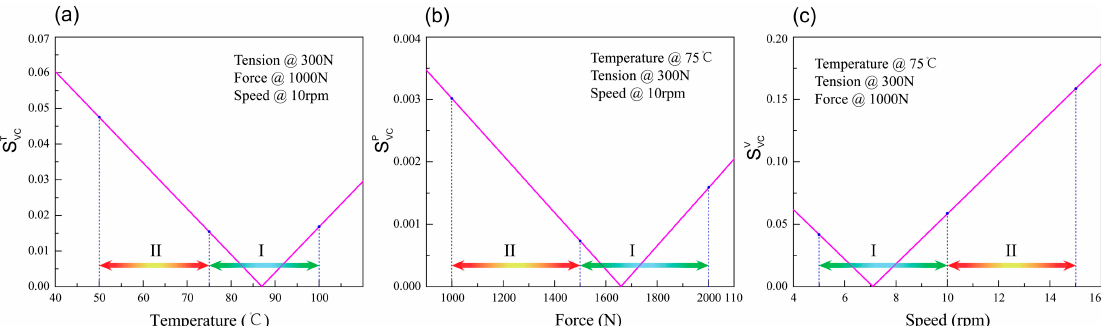
Figure 12. Single-parameter sensitivity curves for process parameters of the void content model. ( a ) Temperature, ( b ) Tension, ( c ) Speed.